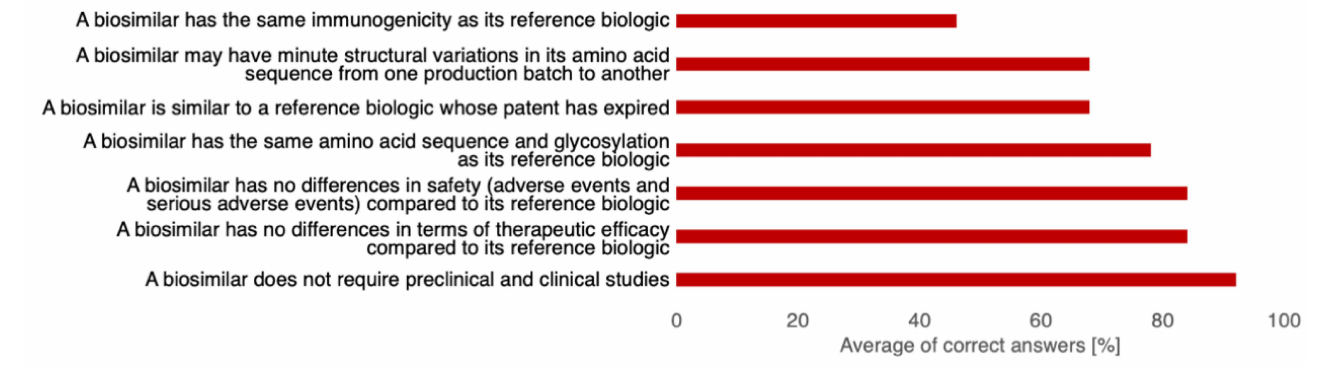
Figure 3. Averages of correct answers for each statement used to calculate the knowledge score. ( n =